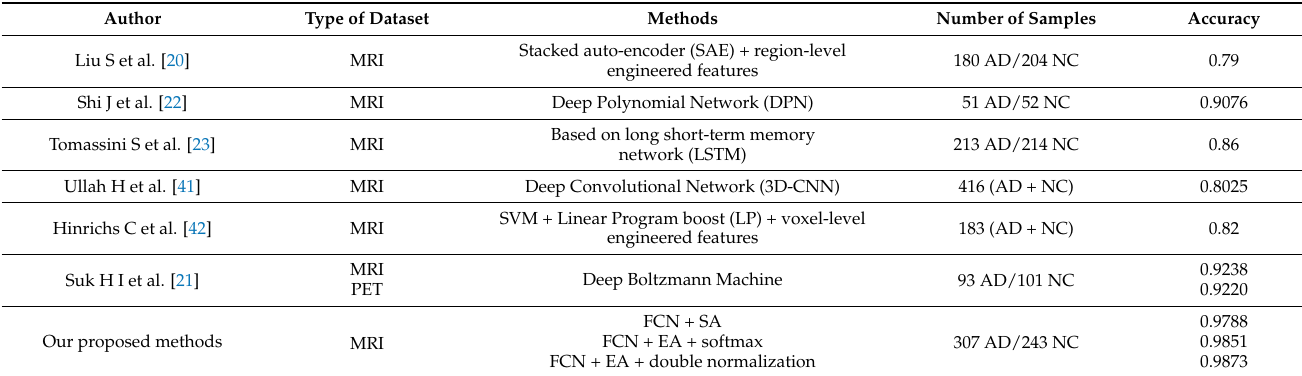
Table 10. Compare with the classification models of other